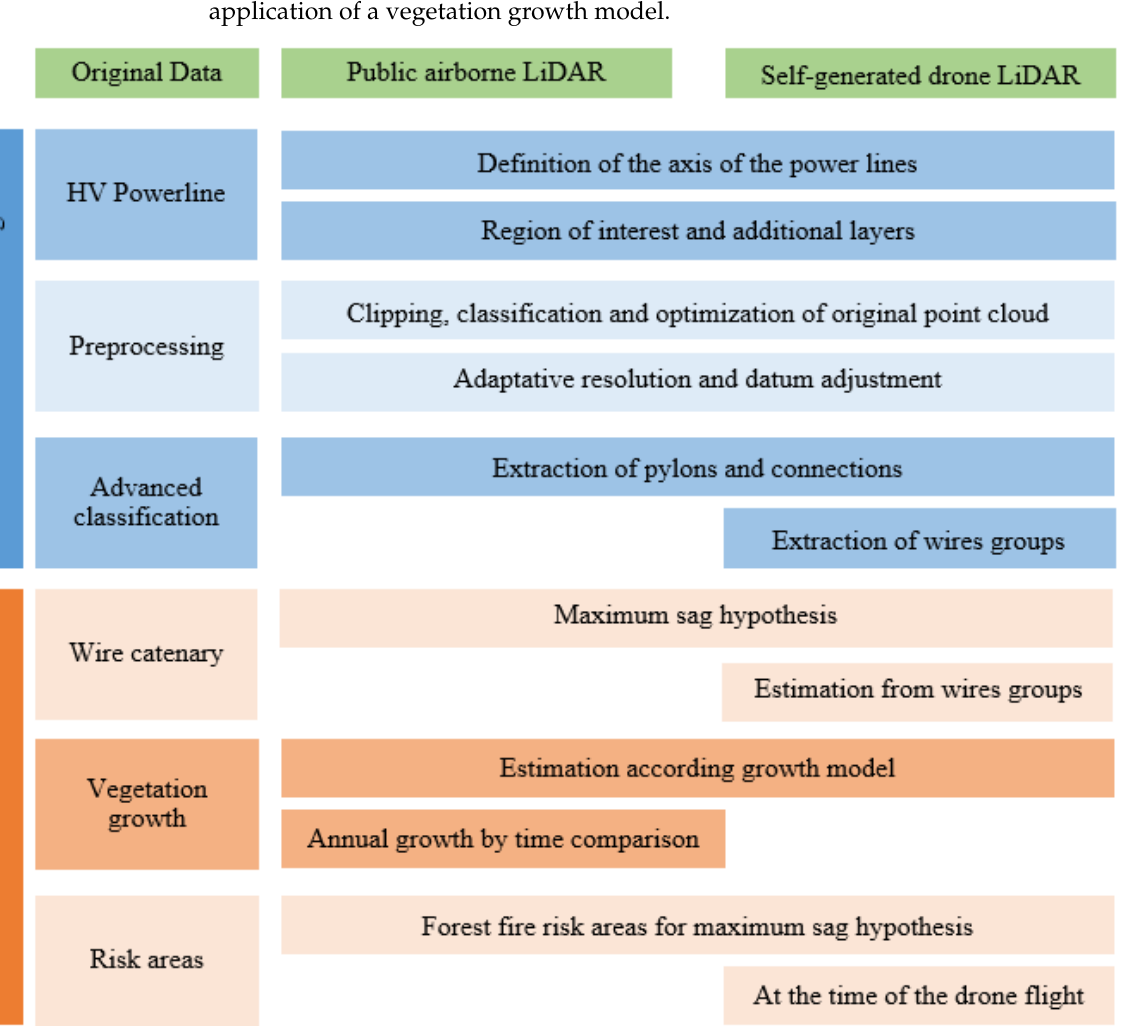
Figure 1. Automatic workflow for the identification of forest fire risk areas along high-voltage power lines using LiDAR data processing.